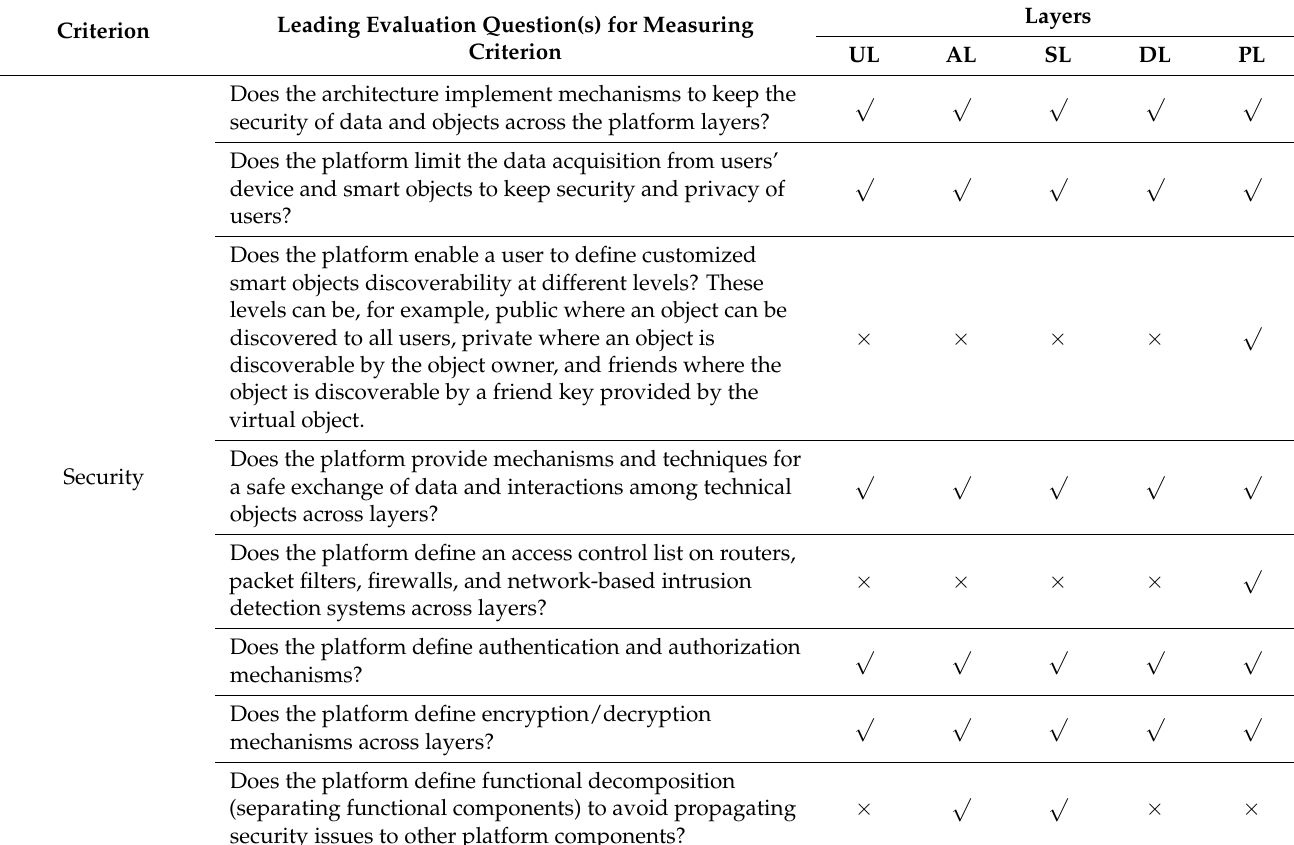
Table 4. Criteria related to assessing IoT platform functions (UL: user interface layer, AL: application layer, SL: service layer, DL: data layer, PL: physical layer,